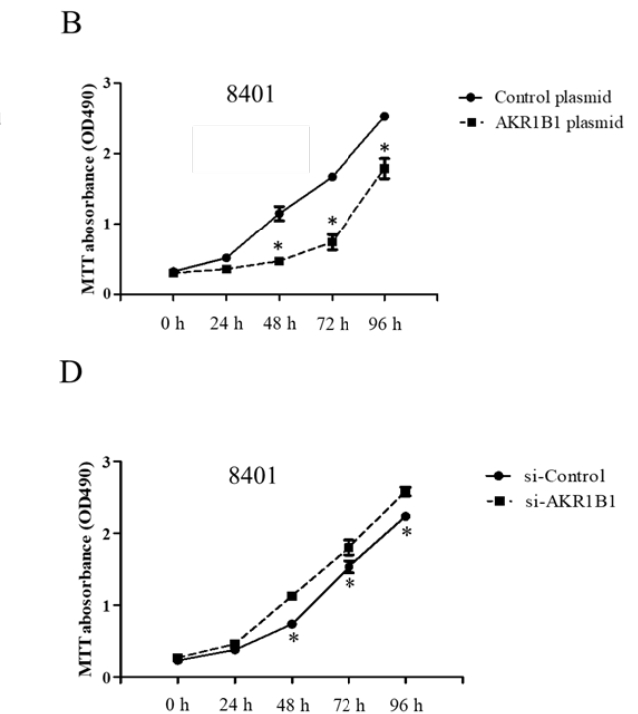
Figure 3. Antitumor effect of ARK1B1 on human glioma cells. ( A , B ) AKR1B1 reduced the cell viability of human glioma cells. T98G cells ( A ) and 8401 cells ( B ) were transfected with the AKR1B1-expressing plasmid. Cell viability was determined by the MTT assay at 0, 24, 48, 72, and 96 h after plasmid transfection ( n = 3/cell type). ( C , D ) AKR1B1 knockdown increased the cell viability of human glioma cells. T98G cells ( C ) and 8401 cells ( D ) were transfected with AKR1B1 si-RNA, and cell viability was determined by the MTT assay at 0, 24, 48, 72, and 96 h after si-RNA transfection ( n = 3/cell type). Data are presented as mean ± SEM from three independent experiments; * p < 0.05.